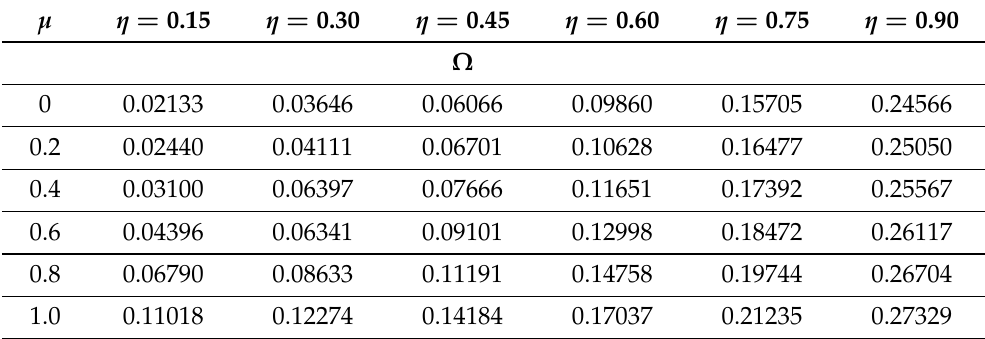
Table 2. Effect of change in µ ∈ [ 0,1 ] for different fractional order η ∈ ( 0,1 ) on stability condition Ω